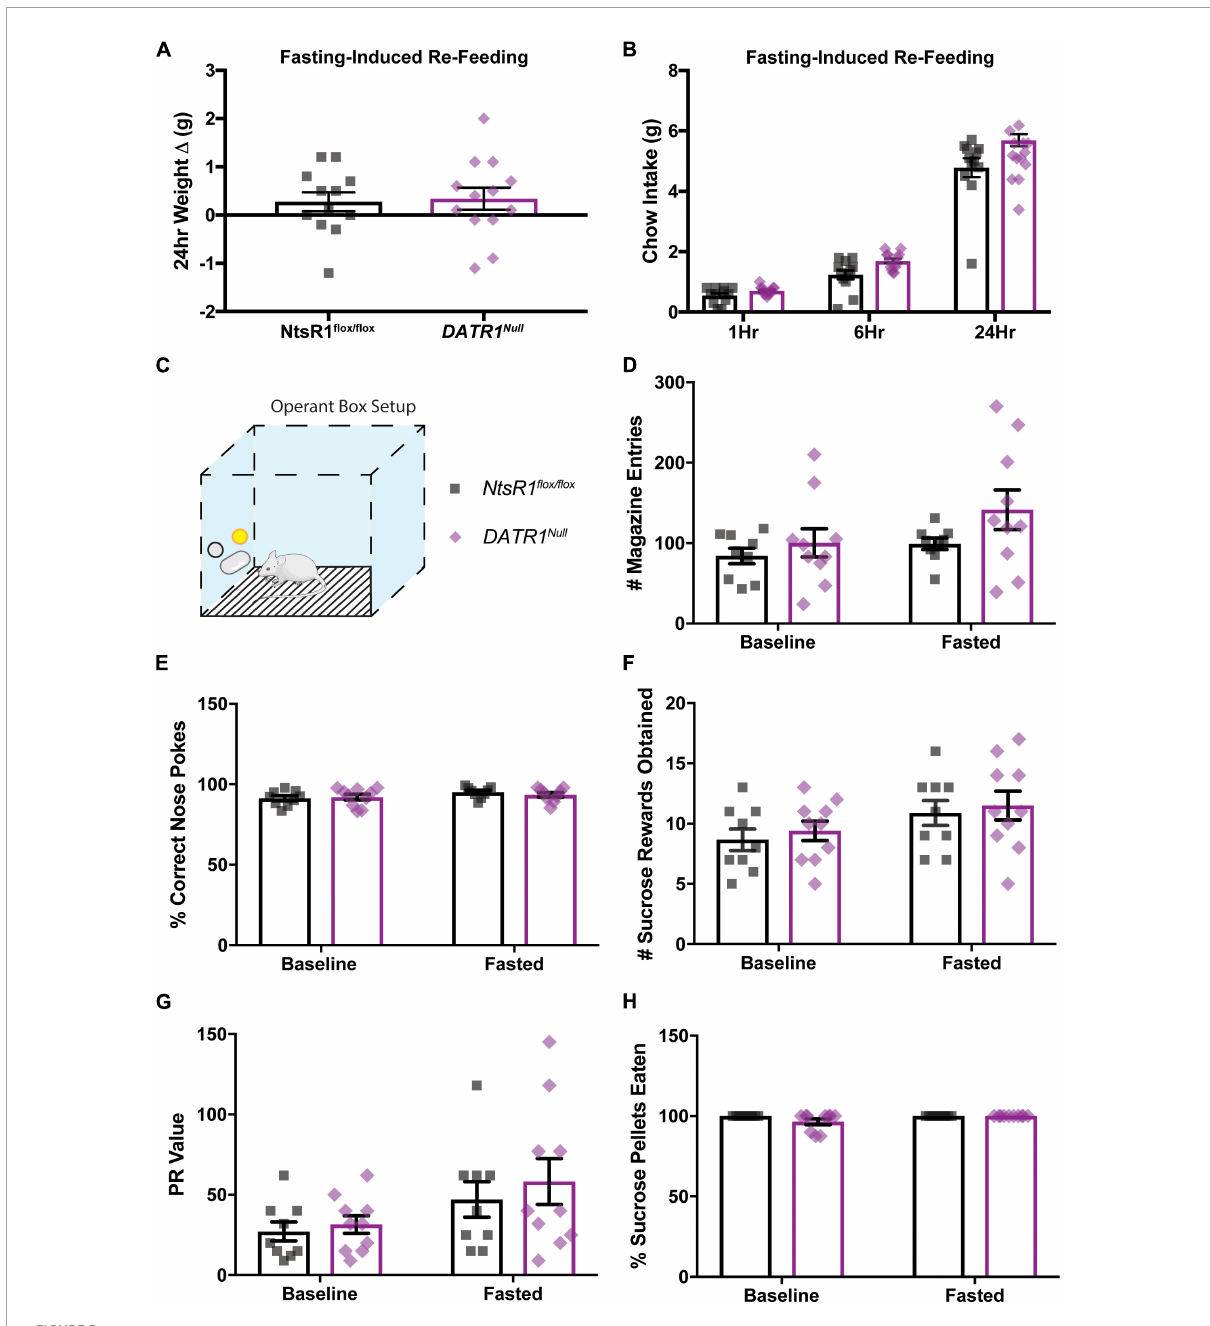
FIGURE3 Developmental deletion of NtsR1 from DA neurons does not alter fasting-induced or operant feeding response. NtsR1 flox / flox and DATR1 Null mice (with developmental deletion of NtsR1 from DA neurons) were fasted overnight. Mice were re-fed the next day with normal chow diet and tested in operant boxes to assess whether developmental NtsR1 deletion decreases DA-mediated food intake. (A) Change in body weight 24 h after food was restored. (B) Chow intake measured 1, 6, and 24 h after chow was restored. After fasting-induced re-feeding studies, mice were tested in operant boxes. (C) Depiction of operant box setup. The position of the correct nose-poke (yellow) was counterbalanced between mice. NtsR1 flox / flox and DATR1 Null were trained to nose poke for sucrose rewards, then were tested on a PR schedule for operant responding during baseline (control, ad libitum chow) and fasted (hungry) conditions. No differences between groups were observed in (D) magazine entries (where sucrose pellet is deposited), (E) correct nose pokes, (F) number of sucrose pellets obtained, (G) PR value (last ratio obtained), and (H) percentage of sucrose pellets eaten. Data were analyzed by Ordinary One-Way ANOVA with Sidak post-tests. Graphs represent mean ± SEM ( n =